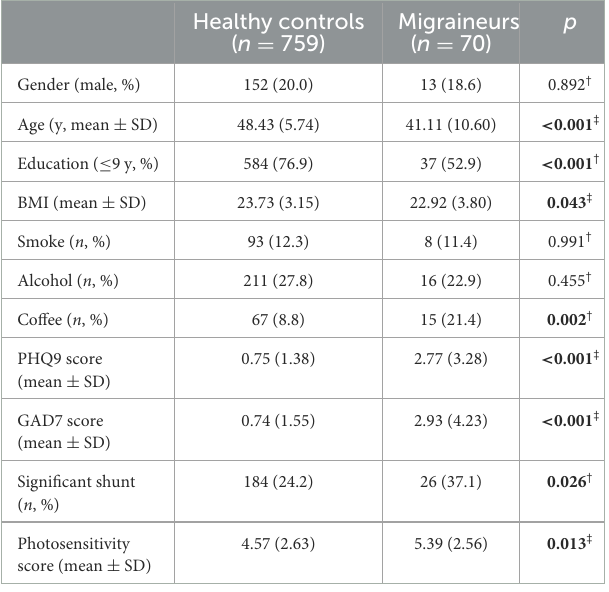
TABLE 1 Unweighted demographic characteristics of migraineurs and healthy